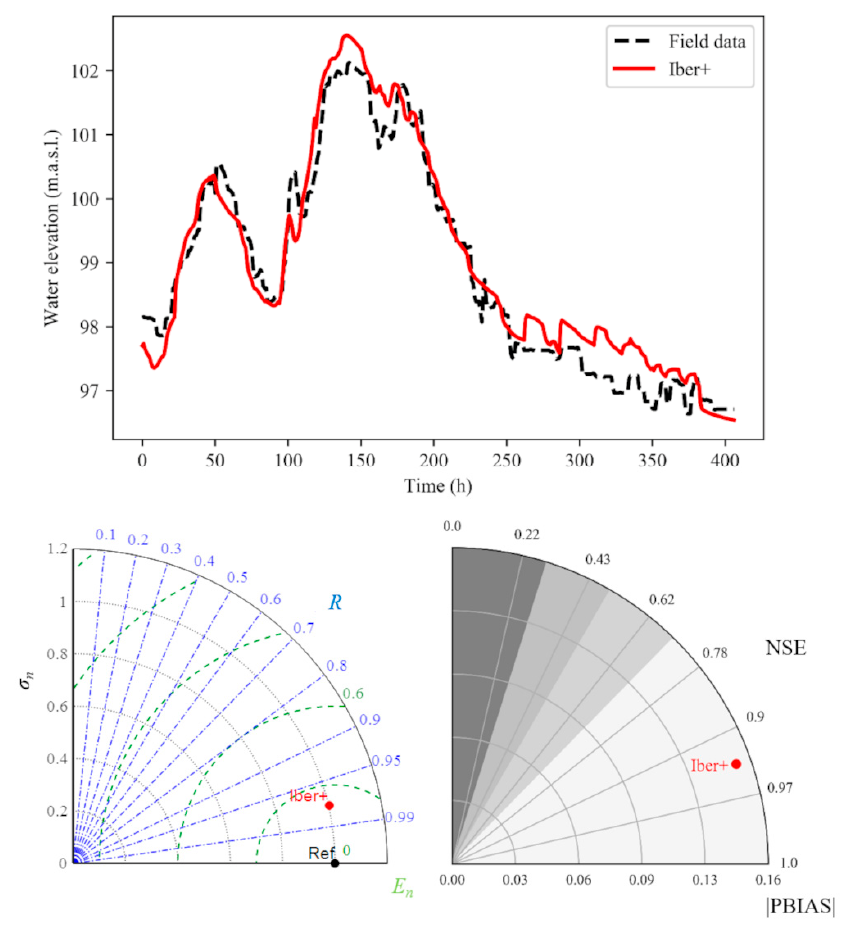
Figure 7. Upper panel: time series of water elevation obtained at gauge station (black dashed line) and using Iber+ (red line) at gauge station N010 (control area B). Lower left panel: Taylor diagram of the time series of water elevation obtained with Iber+ using the field data as reference. Lower right panel: NSE vs. |PBIAS| diagram of the numerical water elevation using the field data as reference. Marker denotes negatives values of PBIAS and shaded areas refer to the criterion of [44] to define the level of accuracy: very good, good, satisfactory, and unsatisfactory (from lighter to darker).